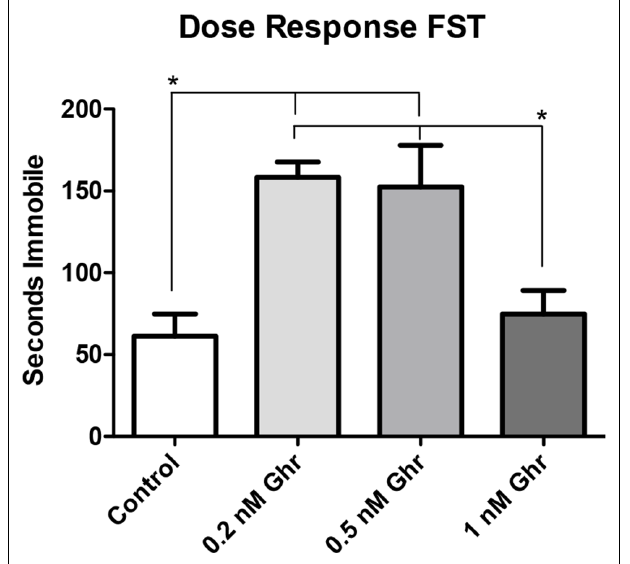
FIGURE 4 | Dose response: forced swim test (FST). Time spent immobile in the FST. Values expressed as mean + SEM (one way ANOVA, p < 0.01), Tukey’s Multiple Comparison Test, ∗ p < 0.05.